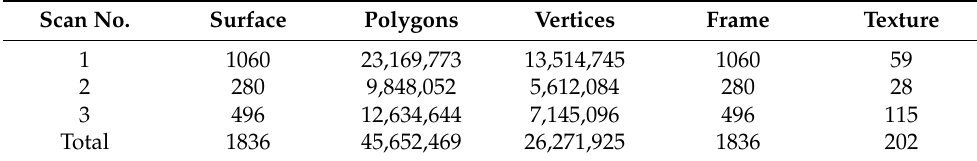
Table 3. Data on scans for an object like a jug.